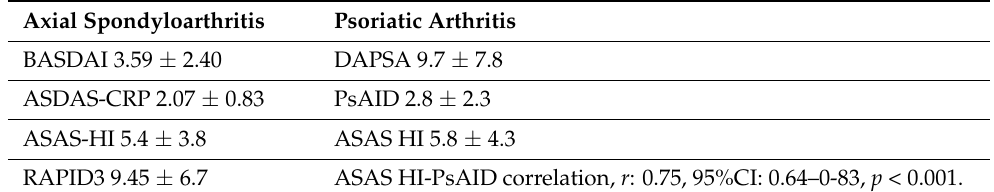
Table 1. Main disease outcomes of both study